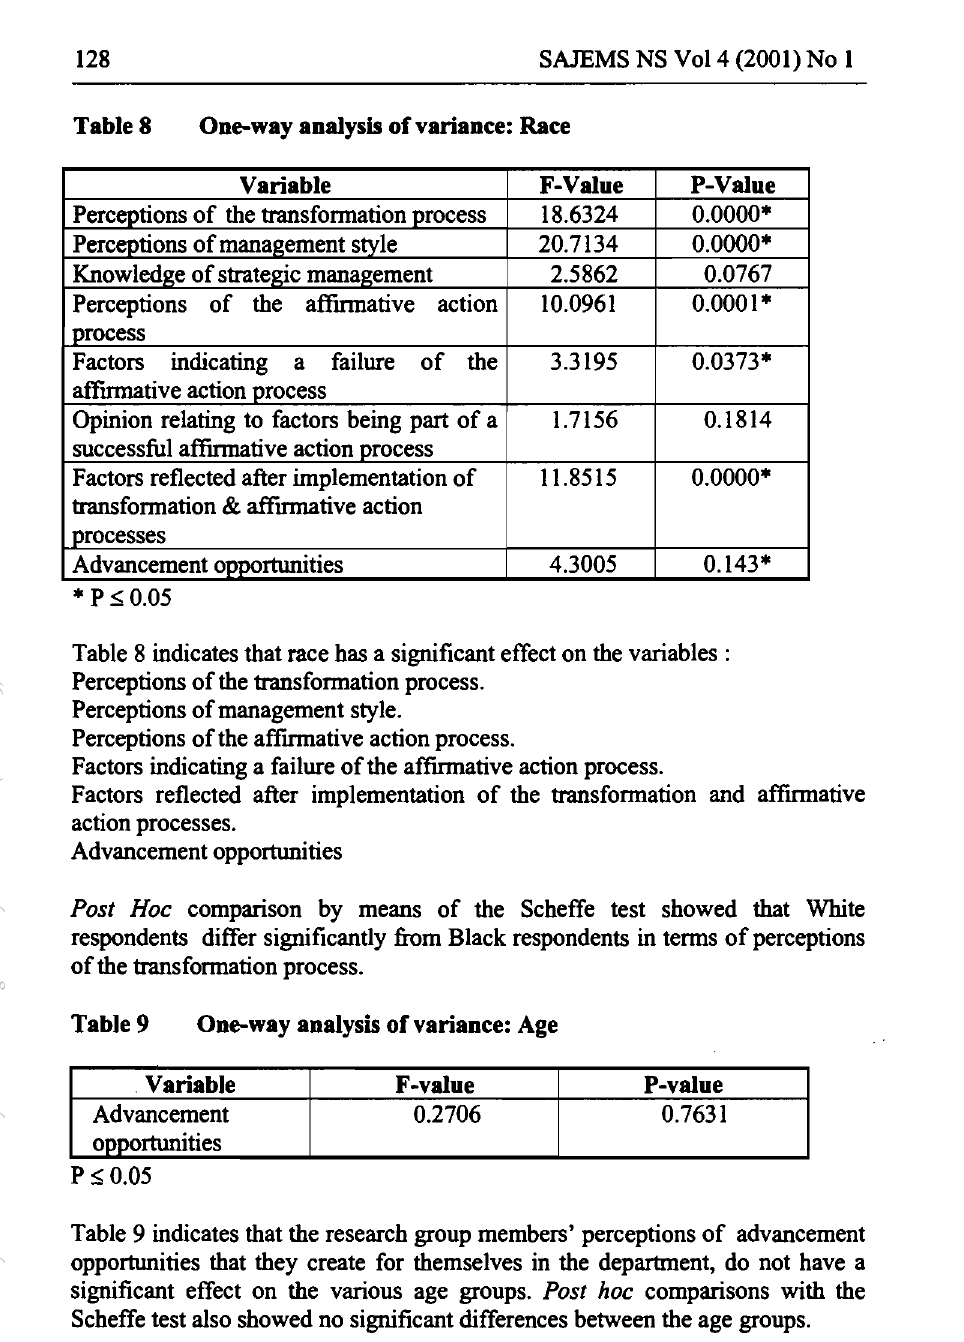
One-way analysis of variance: Race